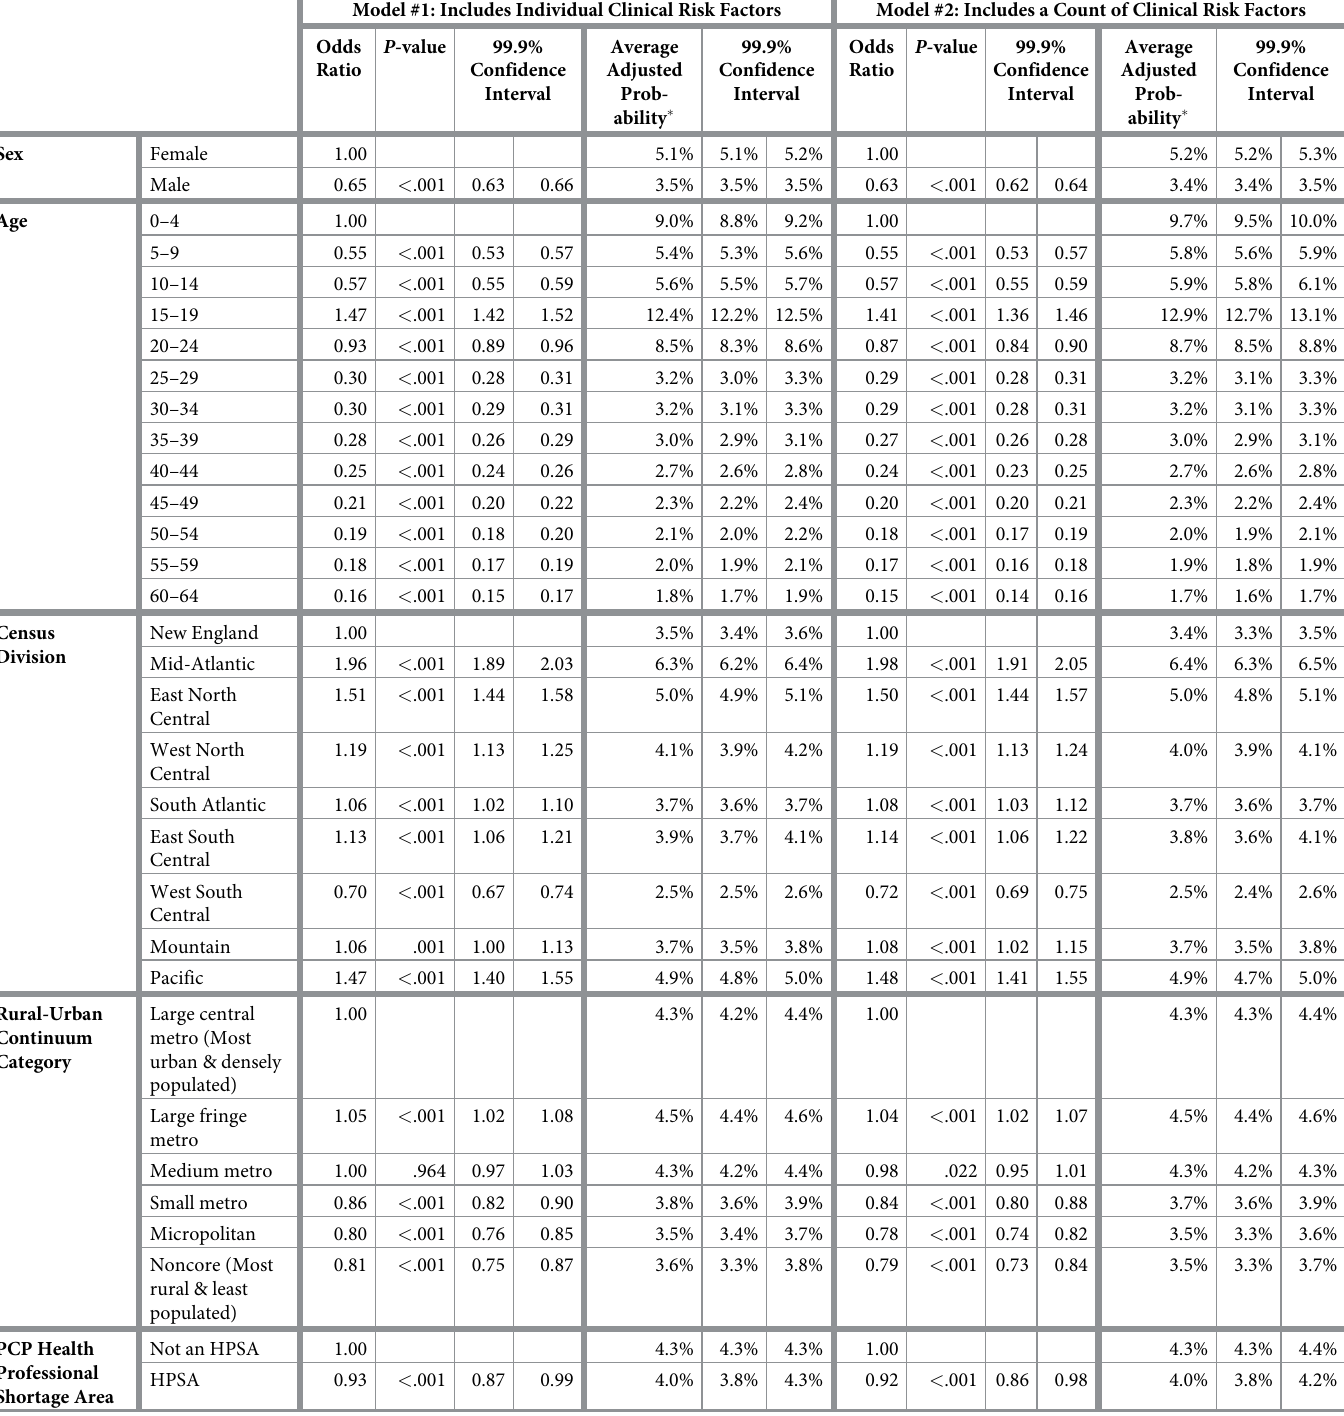
Table 3. Results of two logistic regression models which examine associations between insurance enrollee characteristics and screening for Mycobacterium tubercu- losis with either a tuberculin skin test (TST) or an interferon-gamma release assay (IGRA) between 2011 and 2013, based on data from the Optum Clinformatics Data Mart Database (N =